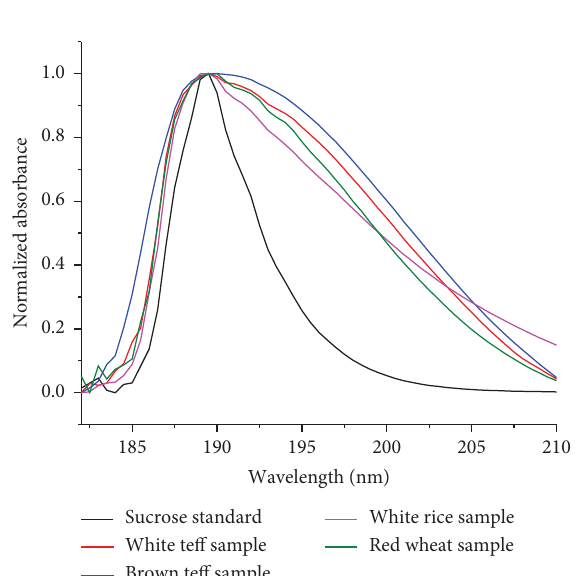
Figure 6: Normalized absorption spectra of the sucrose standard dissolved in water and total sugars in the white tef, brown tef, white rice, and red wheat samples extracted in